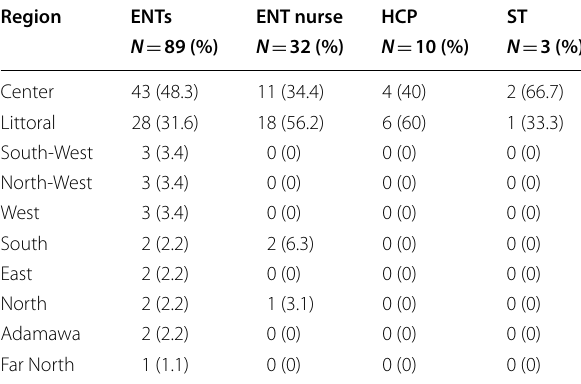
Table 1 Distribution of hearing professionals in Cameroon by administrative region